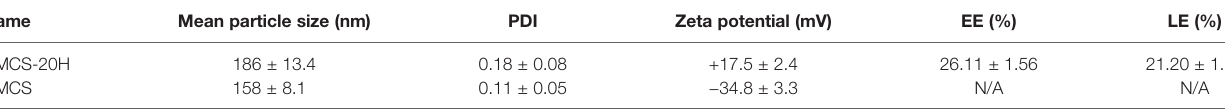
TABLE 1 | Properties of CMCS-20H and CMCS (mean ± SD, n = 3).